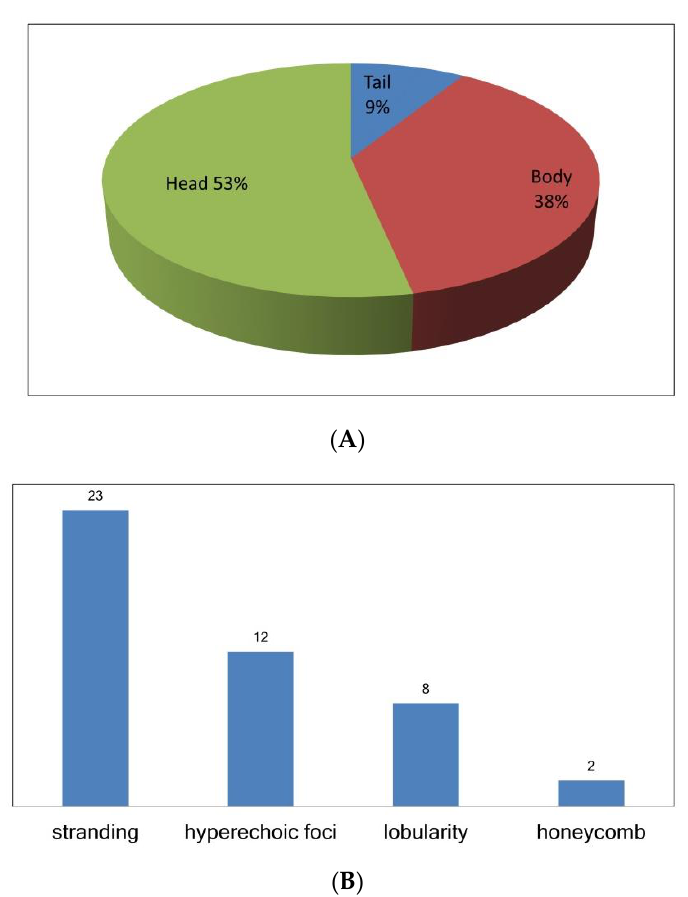
Figure 4. A total of 45 counts of the 4 EUS criteria of pancreatic parenchymal fibrosis in the 13 patients with EUS-diagnosed early chronic pancreatitis; ( A ) the ratio of EUS criteria counts in pancreatic head (including neck, uncinate process), body, and tail; and ( B ) the counts of each EUS parenchyma criteria for pancreatic fibrosis. EUS: endoscopic ultrasonography.